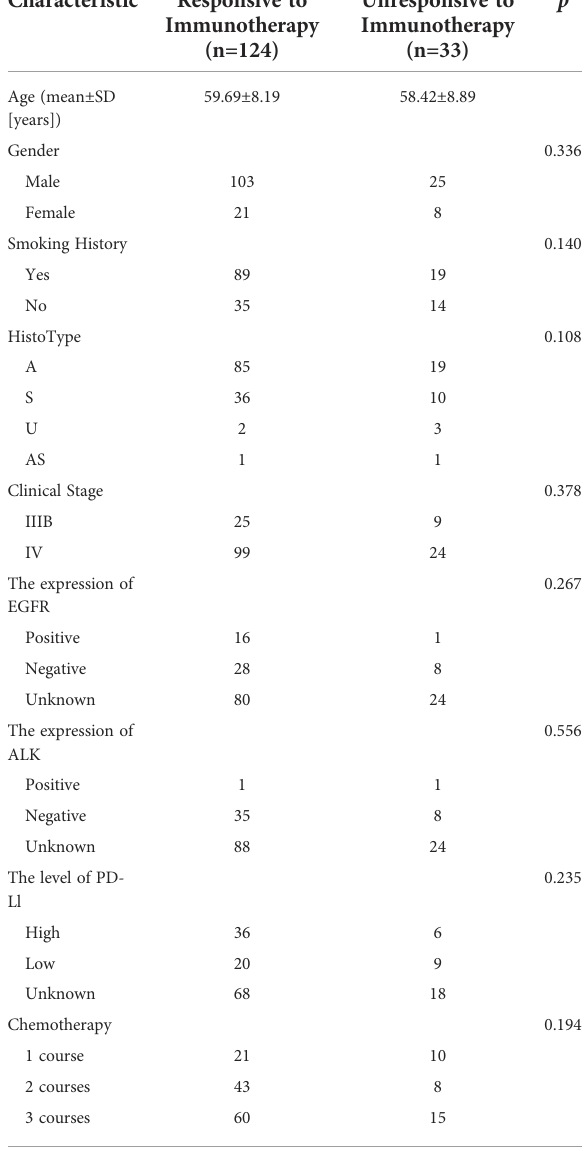
TABLE 1 Demographic and clinical characteristics of patient